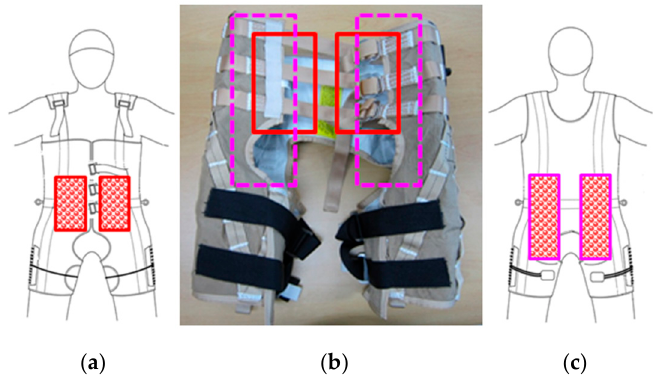
Figure 5. Positioning of air pockets in the harness. ( a ) Front side, ( b ) harness and air pockets and ( c ) back side.